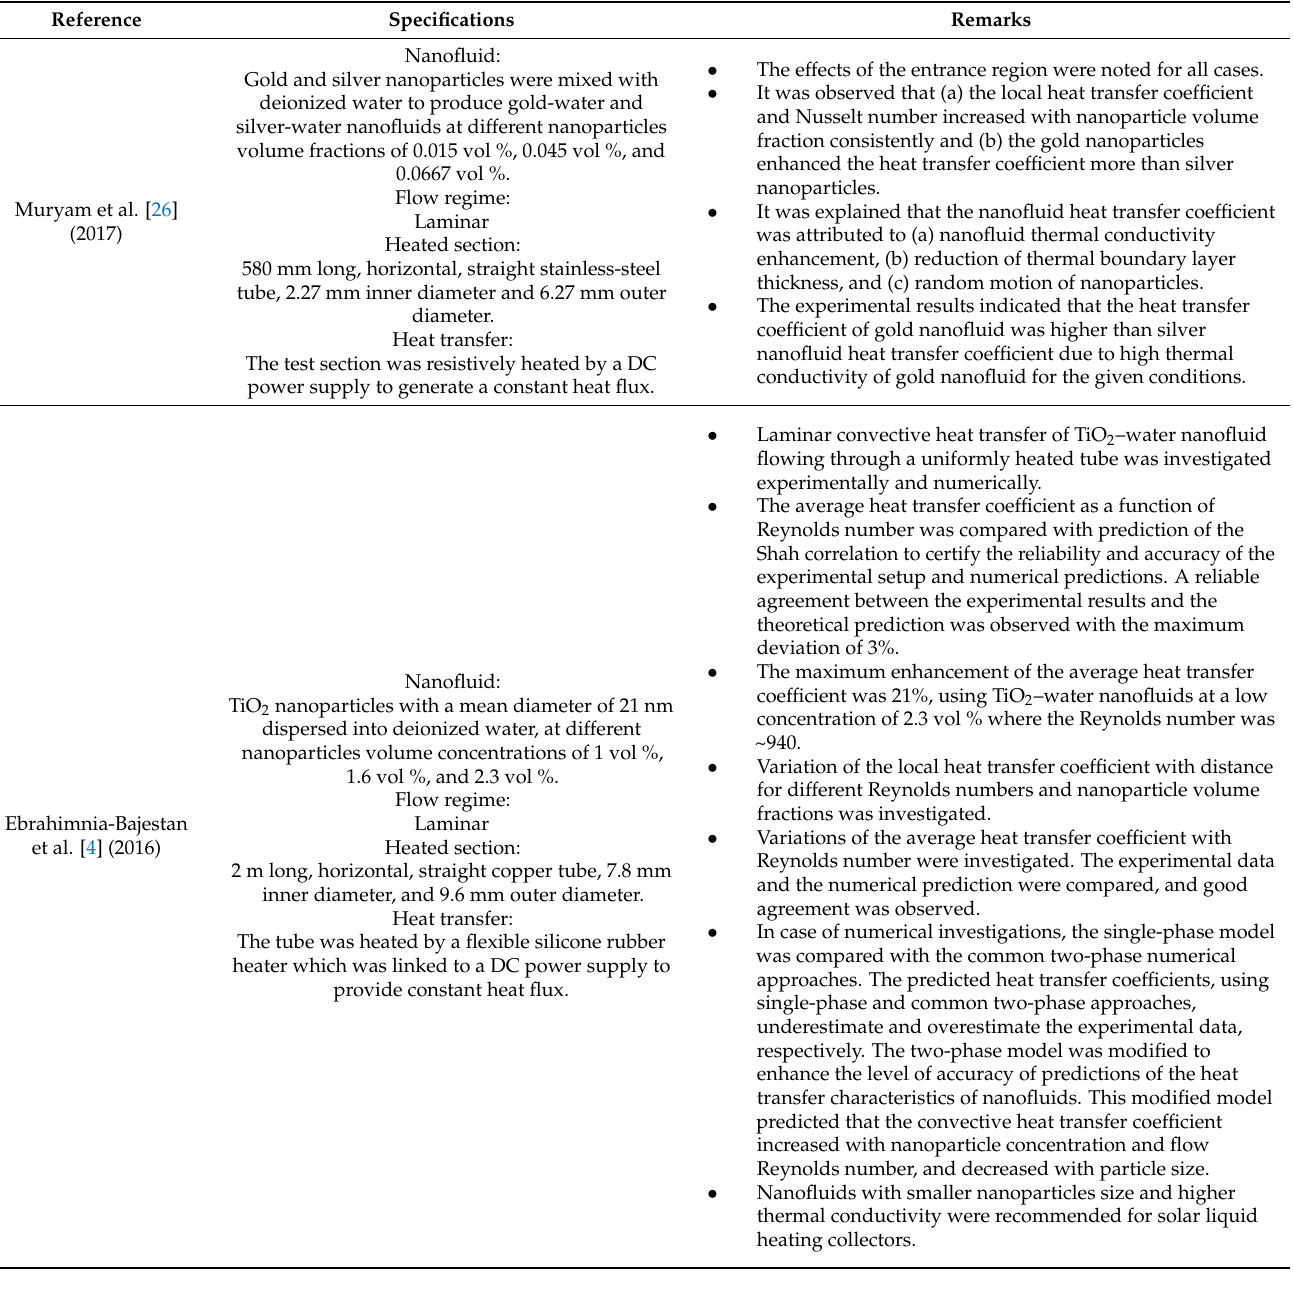
Table A1. Summary of existing experimental investigations related to heat transfer